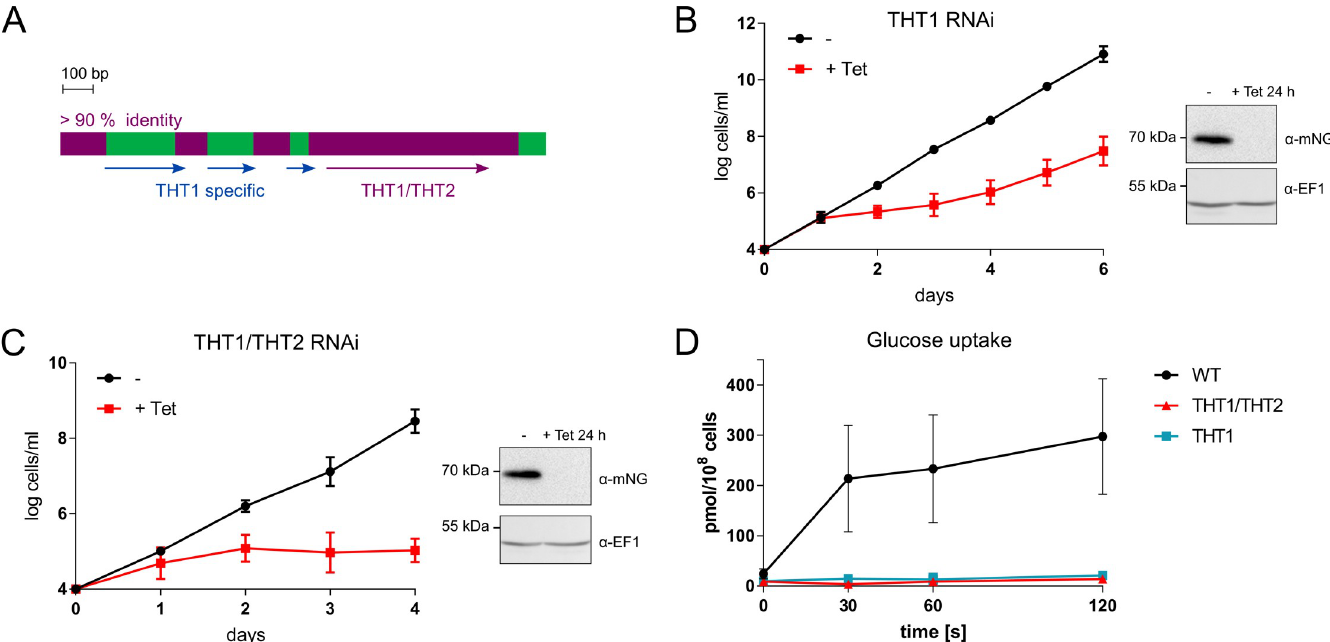
Fig 2. The glucose transporters are essential for growth in vitro . (A) The scheme shows the relationship between THT1 and THT2 genes. > 90% identical regions are depicted in plum and THT -specific regions are in green. The arrows indicate the regions used for RNAi. (B) The growth curves show the THT1 RNAi cell line without and with tetracycline induction. Data points are means of two independent experiments with two biological replicates, error bars, SD. The protein blot shows depletion of native tagged mNG THT1 in the same cell line 24 h after tetracycline induction. (C) The growth curves show THT1/THT2 RNAi cell line without and with tetracycline induction. Data points are means of two independent experiments with two biological replicates, error bars, SD. The protein blot shows depletion of native tagged mNG THT1 in the same cell line 24 h after tetracycline induction. (D) An uptake assay for [ 14 C]2-deoxyglucose showing that this glucose analogue is taken up by wild-type (WT), but not THT1 and THT1/THT2 induced RNAi cells after 3 days tetracycline induction (n = 3). Error bars,